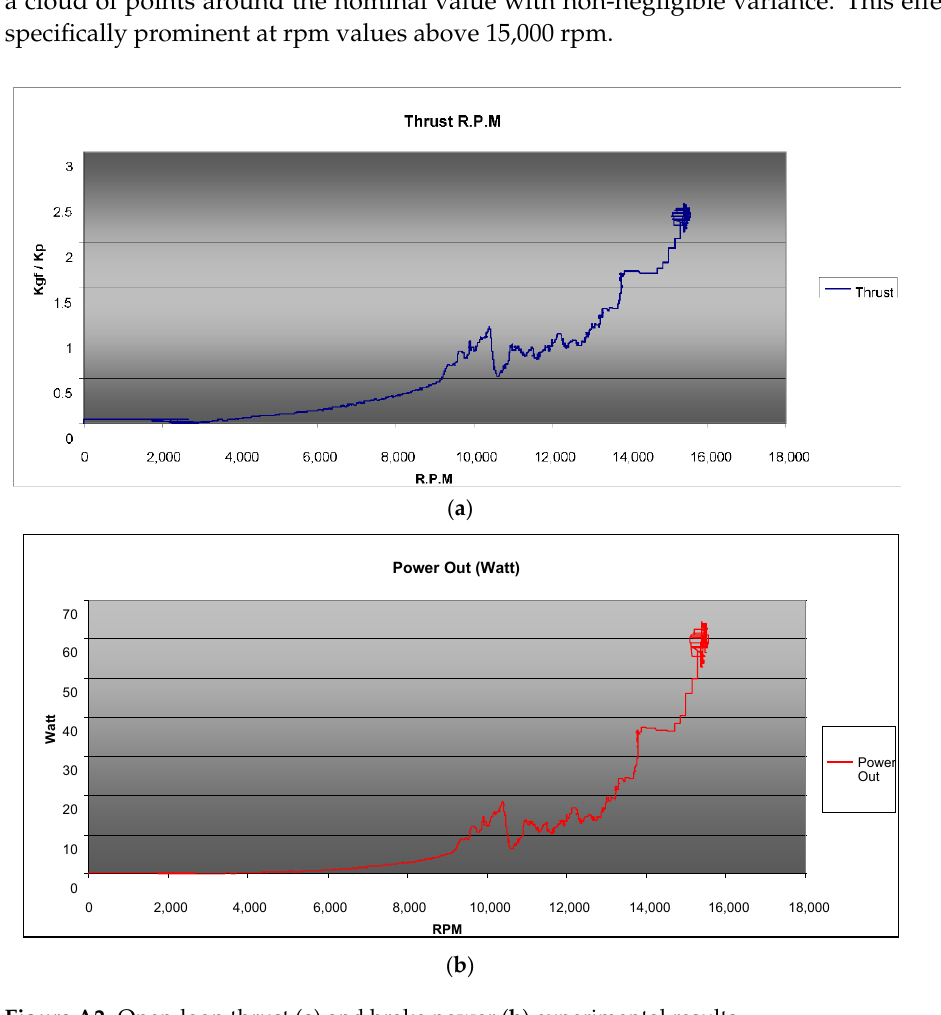
Figure A2. Open-loop thrust ( a ) and brake power ( b ) experimental results.